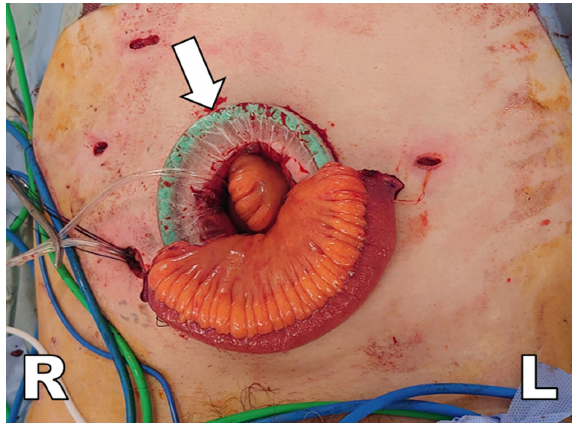
Figure 1. The specimen was removed from the body through an incision in the skin (approximately 4-6 cm). The skin incision was retracted circumferentially and atraumatically using a Smart Retractor® (white arrow), and then a short section of the ileum (15-20 cm) was